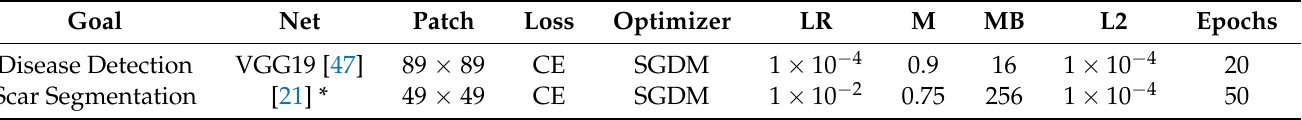
Table 1. Summary of the CNN architectures used in the framework and their corresponding parameters. Goal